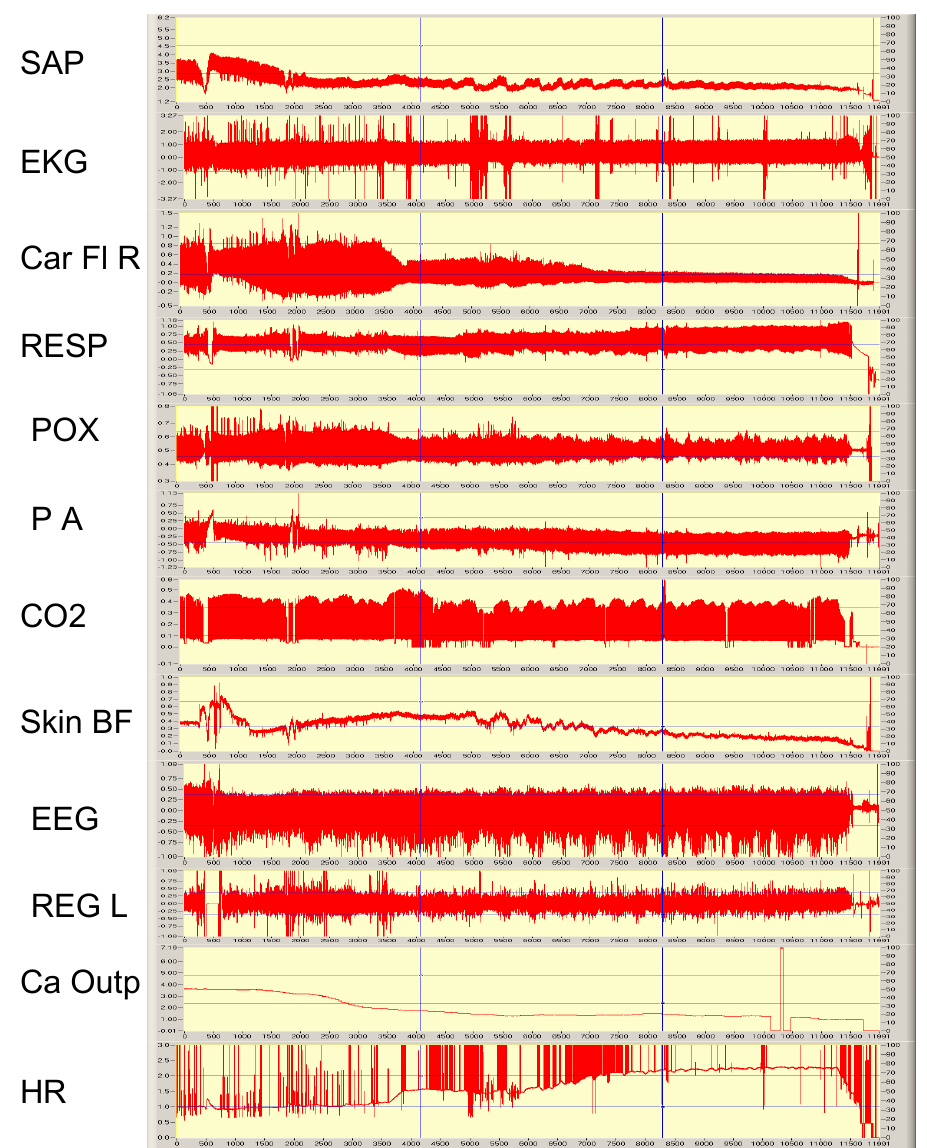
Fig. 4: Polygraphic traces during hemorrhage. Mean arterial blood pressure was 40 mmHg, maintained by a computer controlled system. In the first phase of hemorrhage carotid flow pulse (Car Fl R), pulse oximeter signal (POX) and skin blood flow (Skin BF- measured by LDF; both sensors were placed on nose). REG showed compensatory amplitude increase. The involvement of various organs is represented by different traces. Traces characterize various phases of hemorrhage compensation. The transient POX amplitude increase ended when heart rate (HR) increase indicated the next phase of compensation. There were 3 compensation phases, characterized by 3 levels of CF, HR and respiratory wave amplitudes (RESP). Cardiac output (Ca Outp) reflected only two phases. The pig recording of 7/13/06; time window 199.8